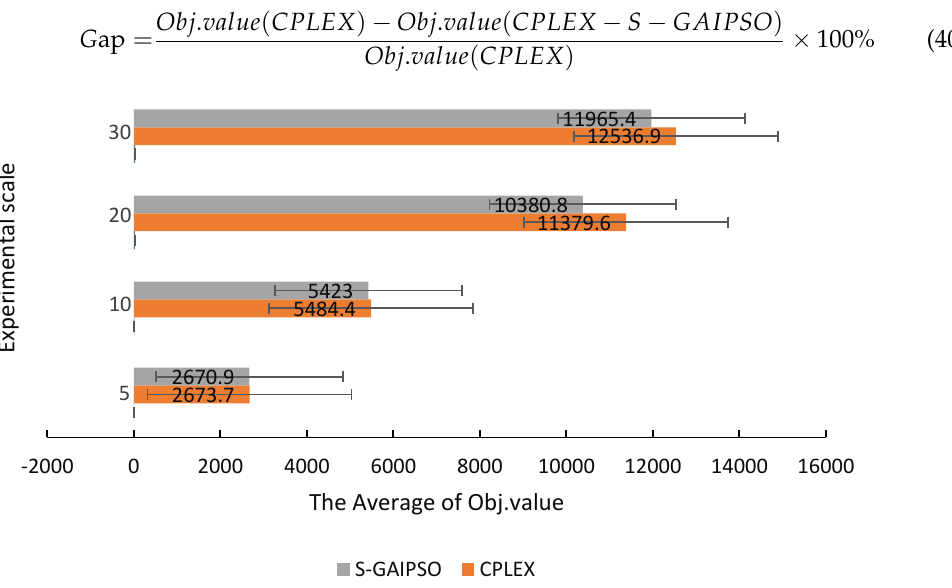
Figure 8. Comparison chart of the average target value under different task scales.